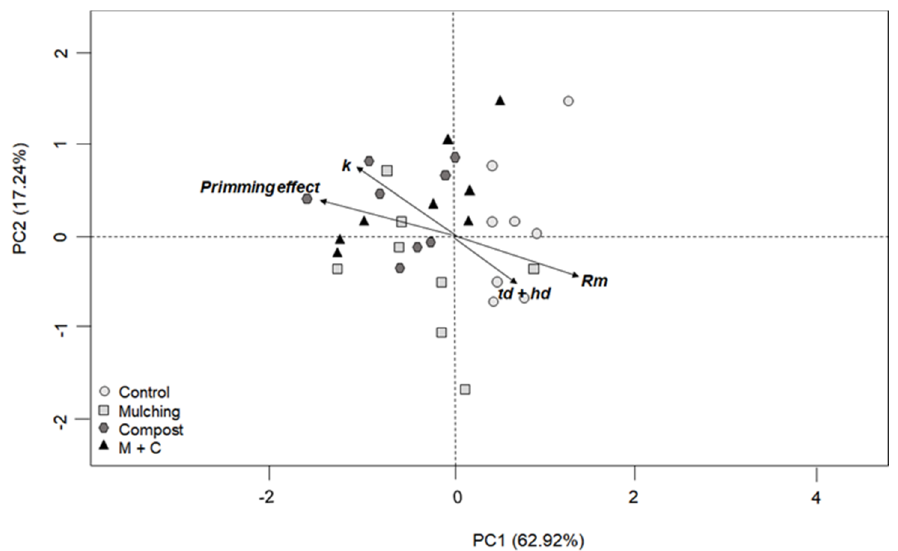
Figure 5. Principal component analysis (PCA) for the litter decomposition data (Primming effect, k, hd, td, and Rm) of different organic residue management. For analysis, primming effect, k, hd (half-decay rate), td (total decay rate), and remaining litter mass (Rm) were included. Organic residue managements are represented as follows: Control = circles; Mulching = squares; Compost = hexagon; and Compost plus mulching = triangles. Only significant vectors are shown ( p < 0.05).